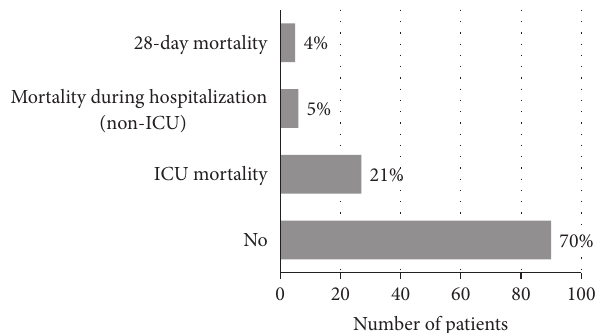
Figure 3: Mortality in non-HIV patients with PCP.